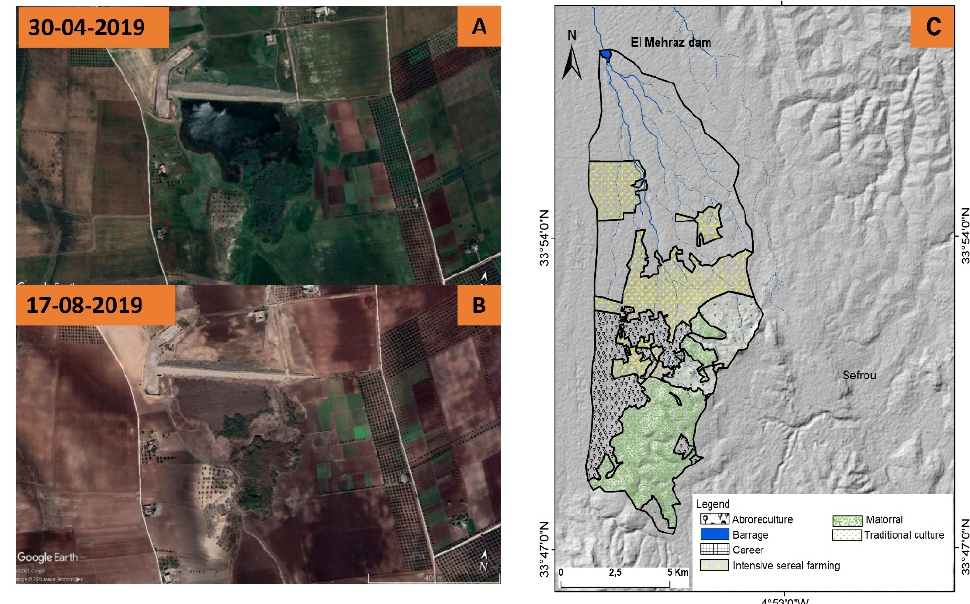
Figure 7. The impact of farmlands developed in the El Mehraz watershed: ( A ) availability of water in the dam reservoir; ( B ) dry reservoir, and ( C ) watershed farmlands.